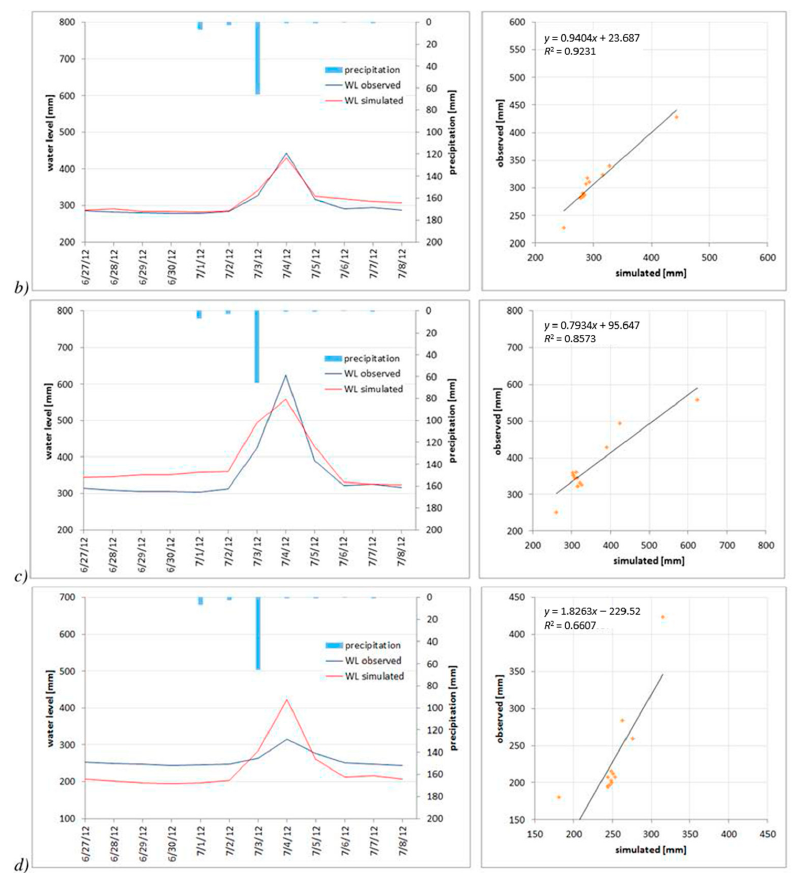
Figure 8. Simulation scenario SC2—single summer storm during 27 June–8 July 2012 at stations: ( a ) RKM; ( b ) JAV; ( c ) ROK; and ( d ) HAJ.